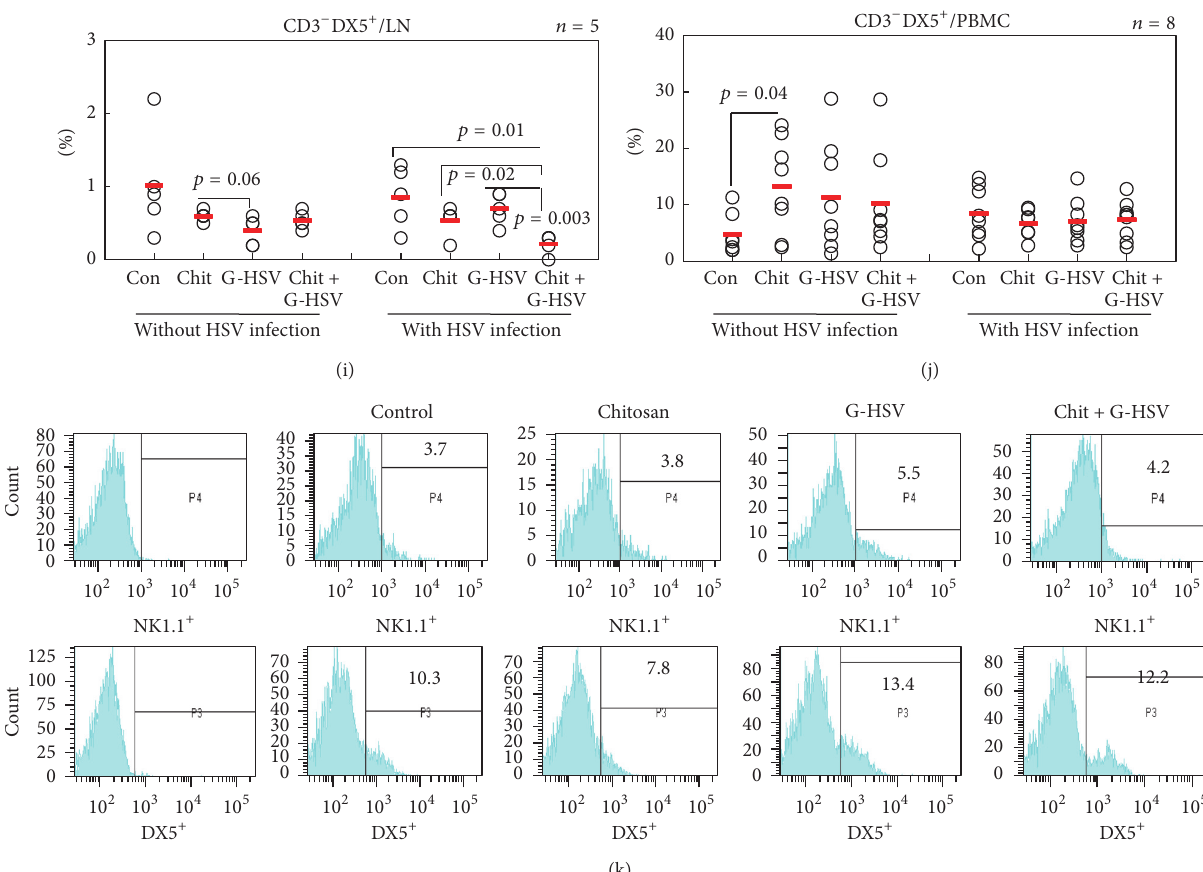
Figure 5: Effect of chitosan on the frequencies of NK cells. The frequencies of NK1.1 were significantly different between mice with HSV infection and those without HSV infection. Chitosan influenced the frequencies of CD3 − NK1.1 + cells in PBMC of mice infected with and CD3 − DX + cells in PBMC of mice without HSV infection. (k) shows the frequency of NK1.1 + and DX5 + cells, respectively, in PBMC with HSV infection. The numbers of mice used were 5 in lymph nodes of each group and 8 in PBMC of each group. In (a) ∗ 𝑝 = 0.03 and ∗∗ 𝑝 = 0.01 . In